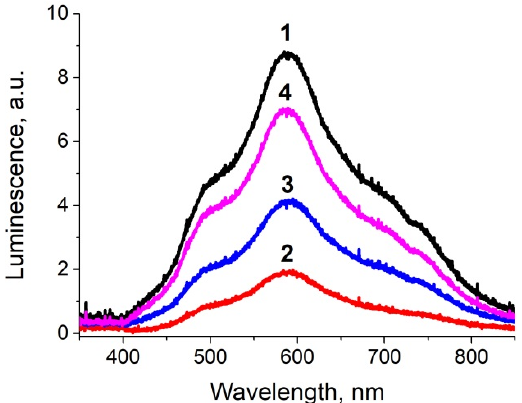
Figure 4. Luminescence spectra of the glass: 1—after silver to sodium ion exchange, 2—after the ion exchange and annealing in hydrogen (glass with Ag NPs), 3—after 1-day exposure to PBS, 4—after 4-day exposure to PBS. The excitation wavelength was 365 nm.